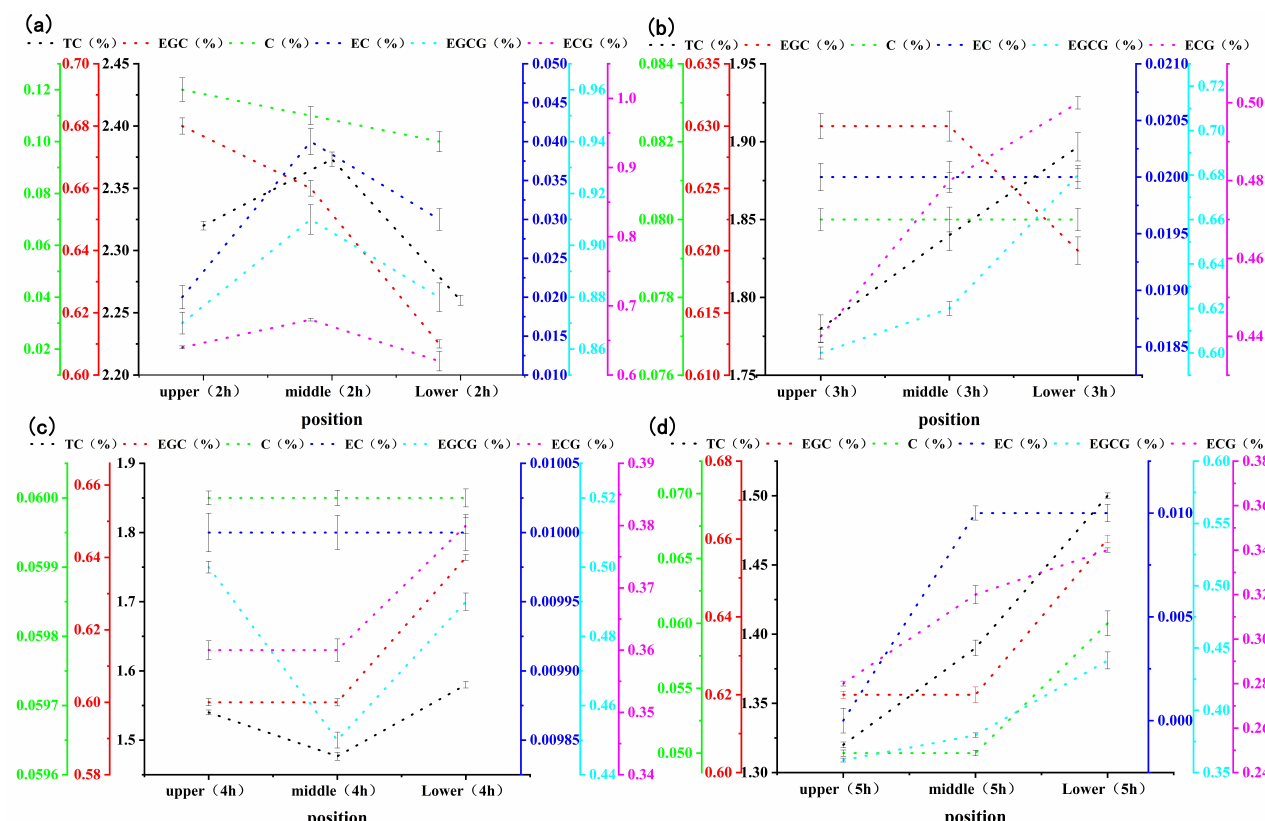
Figure 3. Changes in catechin content in the fermented leaves of stacked black tea at different fermentation levels and positions. (( a – d ) are the changes in the content of catechin components at different positions during the fermentation of black tea for 2, 3, 4, and 5 hours,